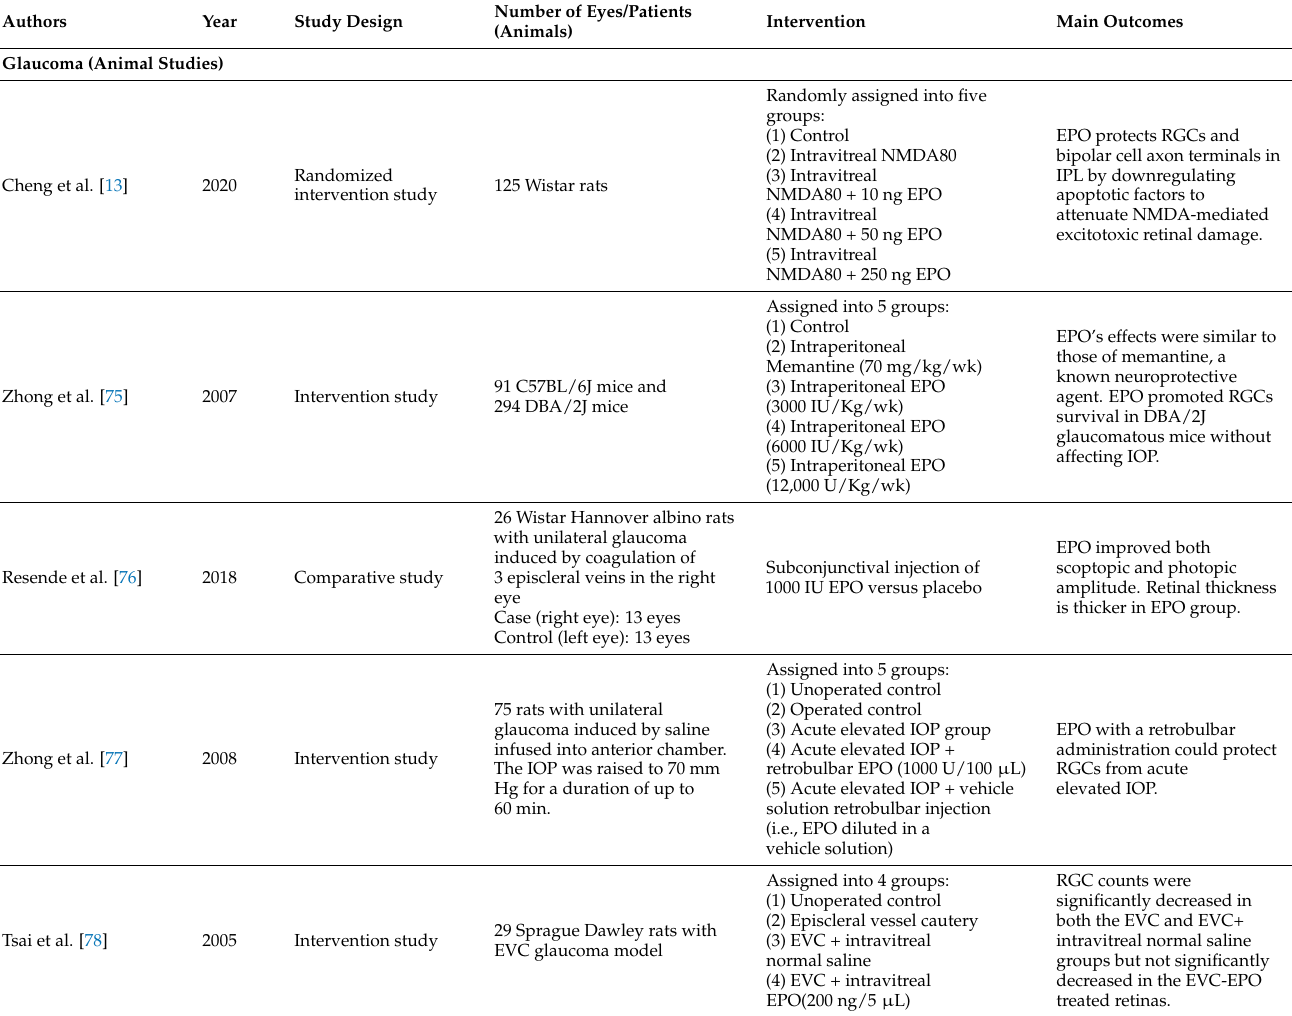
Table 1. Summary of clinical studies that evaluate the effect of erythropoietin on optic